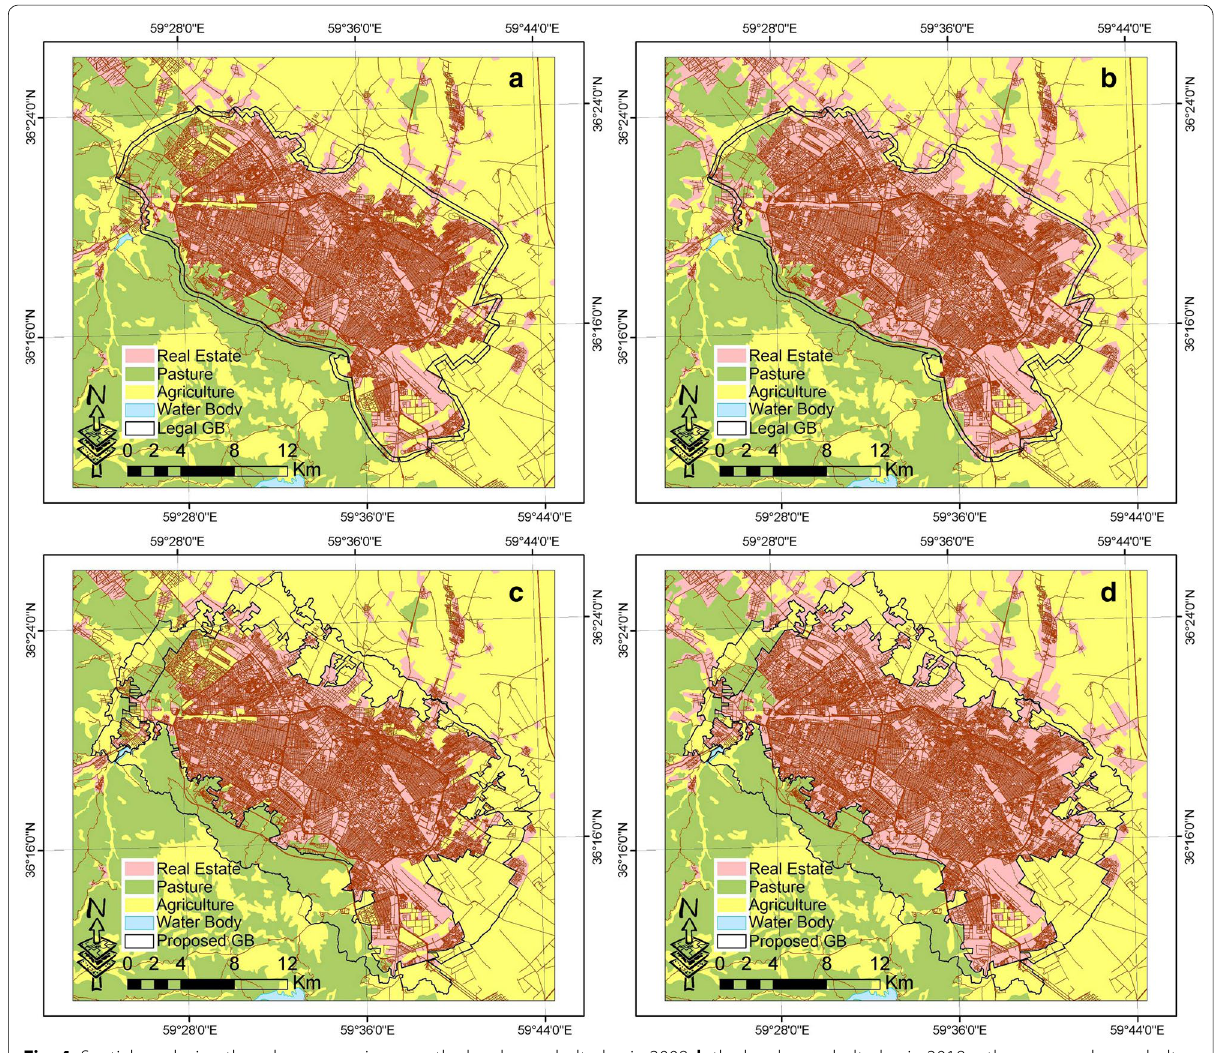
Fig. 4 Spatial overlaying the urban expansion on a the legal greenbelt plan in 2008, b the legal greenbelt plan in 2018, c the proposed greenbelt plan in 2008, and d the proposed greenbelt plan in